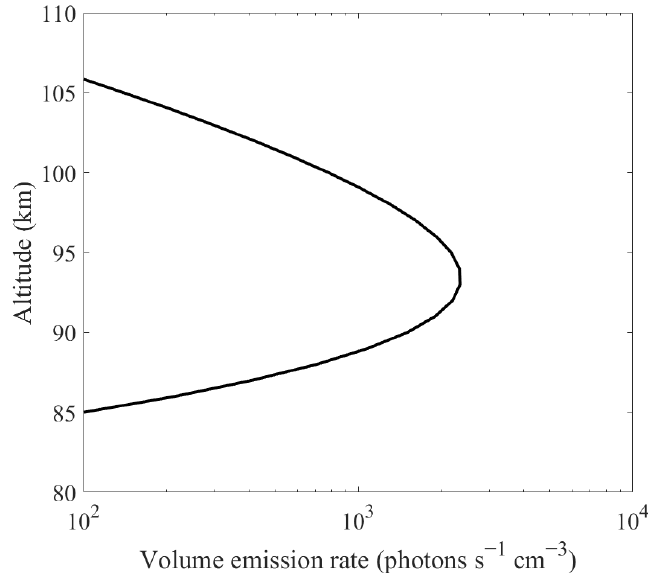
Figure 1. The simulated VER of the O 2 A -band nightglow at 30° N and 80° E and local solar time at 22:00. For O 2 A -band airglow, the rotational band under thermodynamic equilibrium obeys Boltzmann distribution at rotational temperature. Based on the rotational band structure, the number of radiated photons is distributed on the narrow emission line within the band, represented by η rot below. The normalized fine spectral structure of A -band airglow is shown in Figure